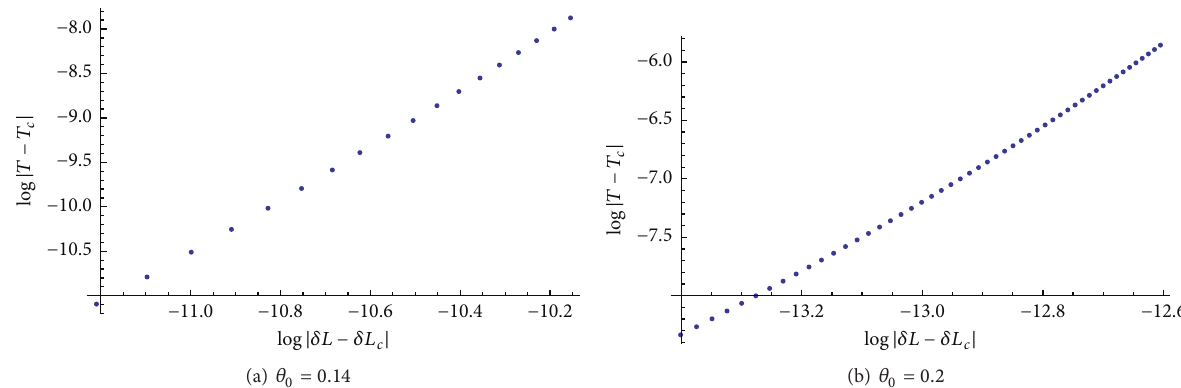
Figure 5: Relation between log |𝑇 − 𝑇 𝑐 | and log |𝛿𝐿 − 𝛿𝐿 𝑐 | near the critical point of second-order phase transition for different 𝜃 0 .